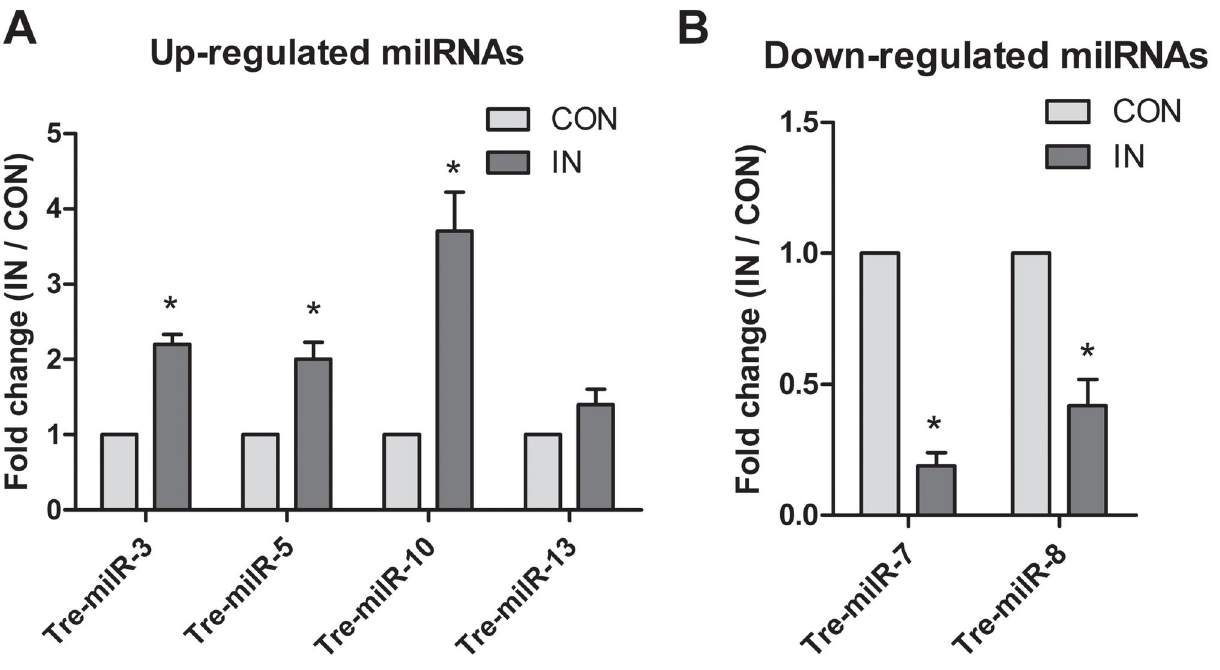
Figure 4. Validation of differentially expressed milRNAs obtained in high-throughput sequencing with S-Poly(T) RT-qPCR method. The expression levels of the selected milRNAs were assayed in both IN and CON. The 18S rRNA was used as a normalization control and the CON was served as the reference sample. All analyses were performed in biological triplicate. Statistical analysis was performed using a two-tailed Student’s t-test. Each bar represents mean ± SD. * P <0.05. doi: